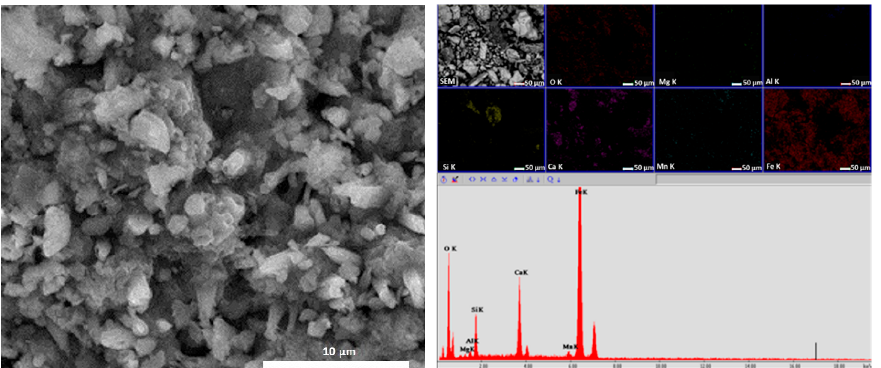
× and EDX associated.